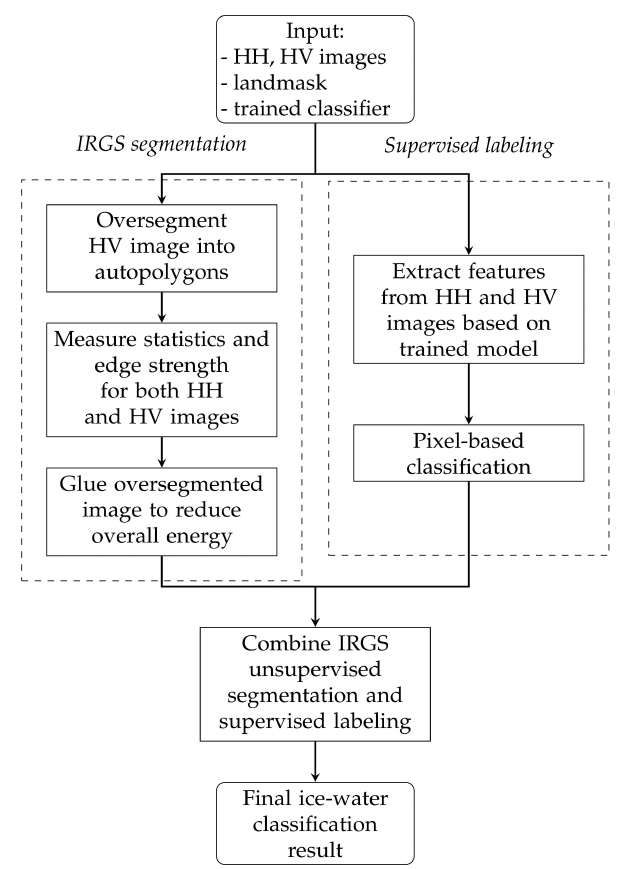
Figure 3. Flowchart of ice-water classification system. Inputs are images, landmask, and trained classifier (SVM or RF). The left block is unsupervised segmentation using IRGS, while right block is supervised pixel-based labeling. The final classification result is the combination of segmentation and labeling based on majority